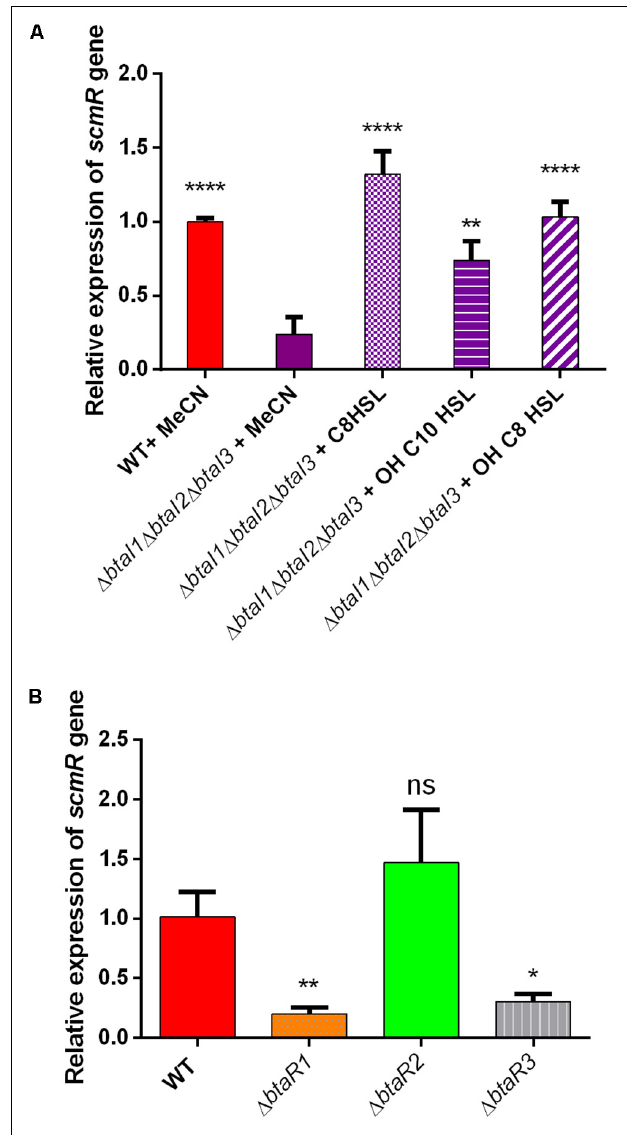
FIGURE 6 | QS-1 and QS-3 activate the transcription of scmR . (A) The relative transcript levels of scmR in the B. thailandensis E264 wild-type and the (cid:49) btaI1 (cid:49) btaI2 (cid:49) btaI3 mutant strains were determined by qRT-PCR. Cultures were supplemented with 2 µ M of C 8 -HSL, 3OHC 10 -HSL,